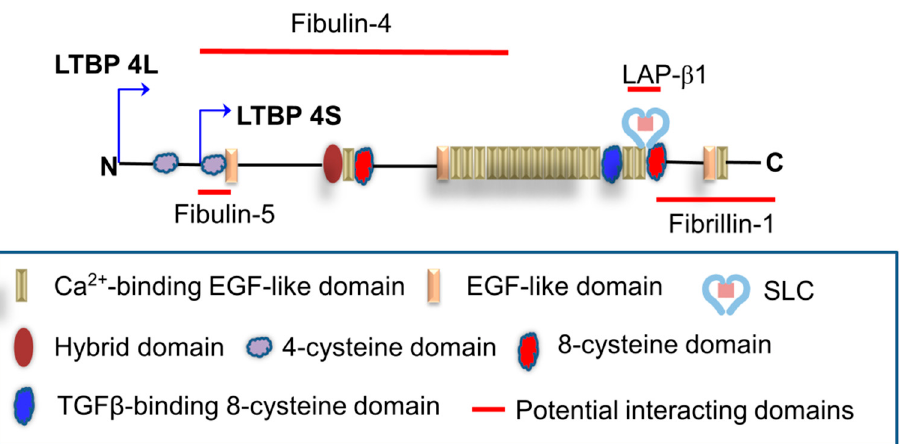
Figure 1. Potential binding between LTBP4 and matrix proteins. EGF: Epidermal growth factor; SLC: Small latent complex; LAP: Latency-associated peptide.